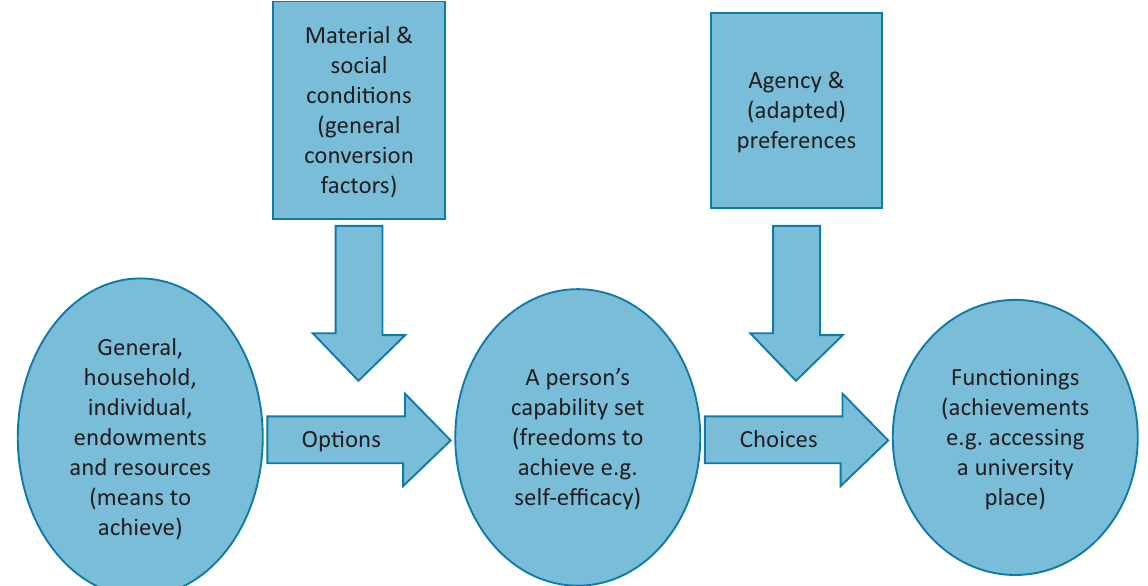
Figure 1. Adaptation of DeJaeghere and Baxter (2017, p.